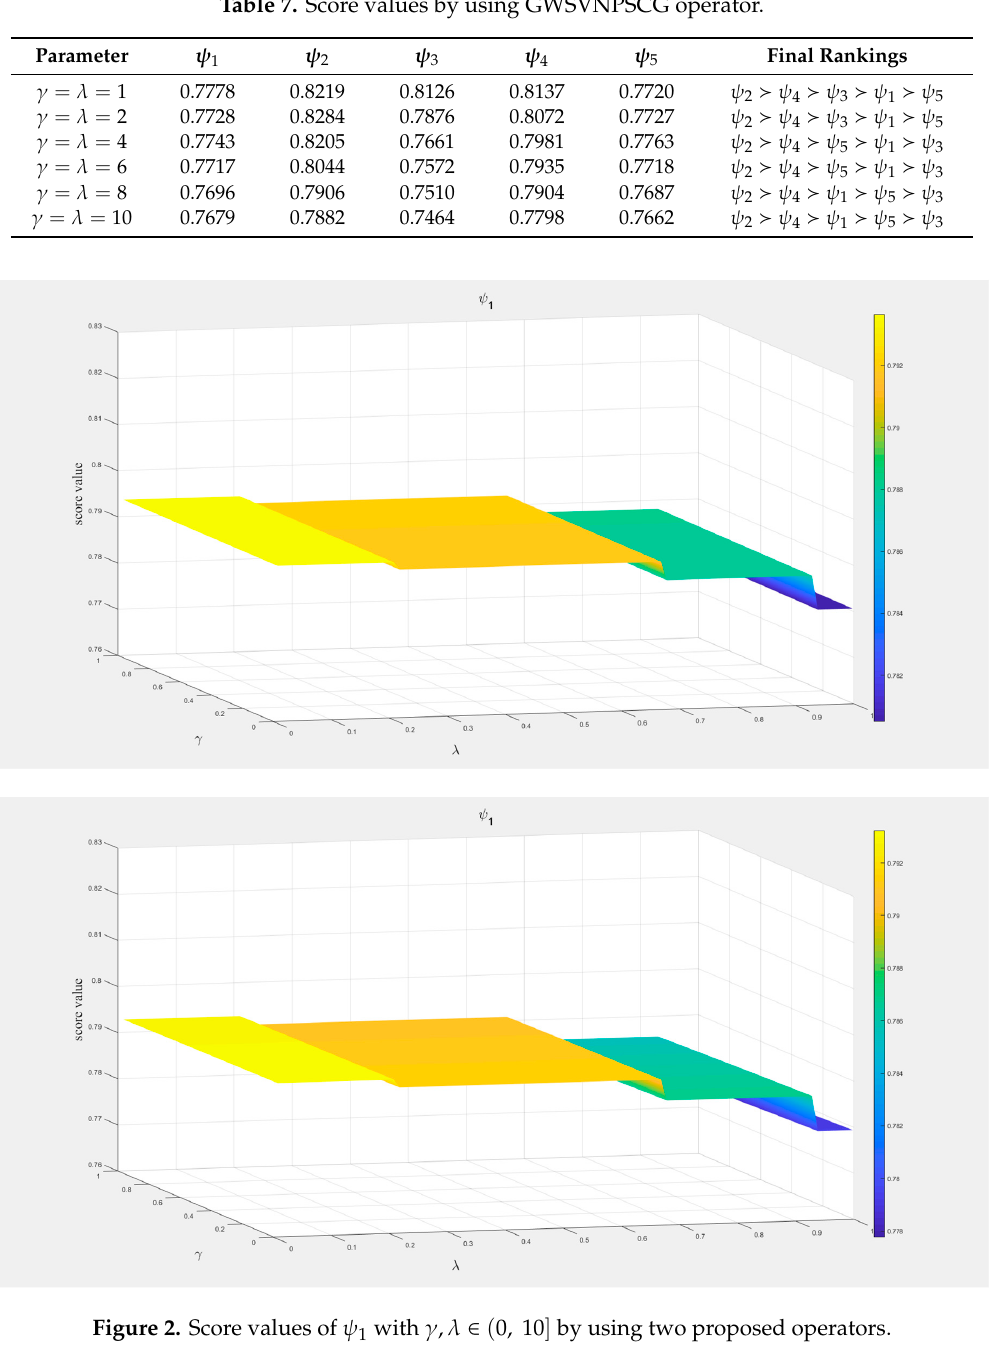
Table 7. Score values by using GWSVNPSCG operator.